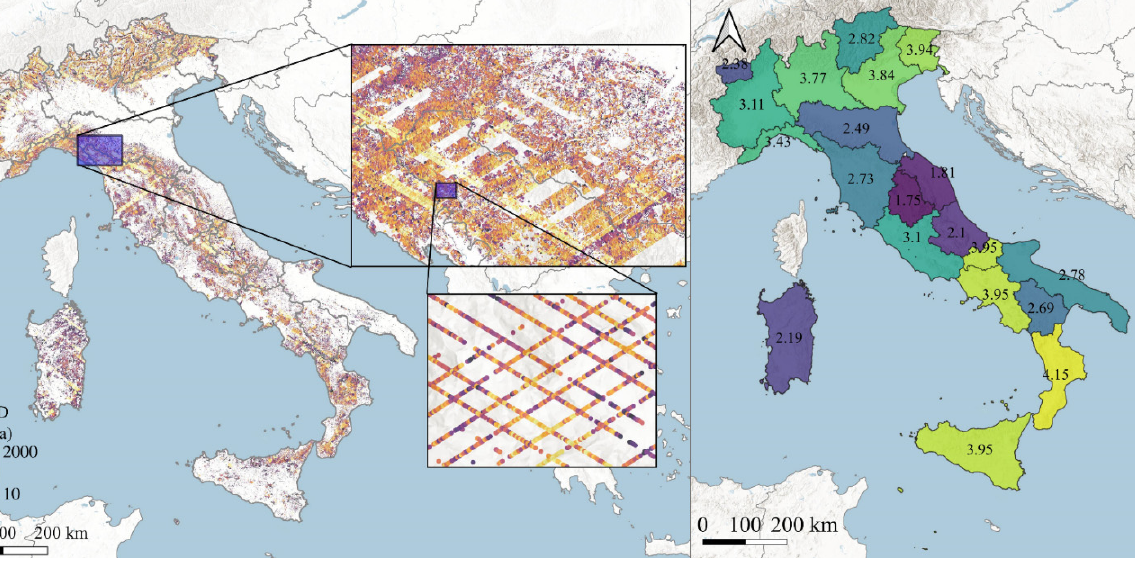
Figure 3. Left—scatter plot of aggregated AGBD and CHM with the blue line showing the linear correlation. Right—a map indicating the different correlations for each Italian region. According to our automatic procedure (Section 2.4), 1,793,802 forest disturbances oc- curred in Italy between 1985 and 2019 (Figure 4). In terms of area, they covered approxi- mately 3 million hectares, corresponding to 27% of the total Italian forest area. The average area of the predicted disturbance was 1.72 ha, while the median value was 0.83 ha. The